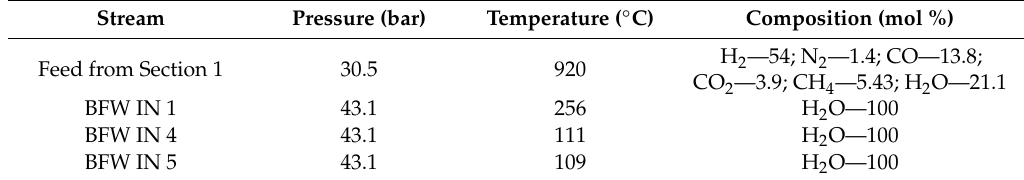
Table 3. Feed stream conditions in Section 2.